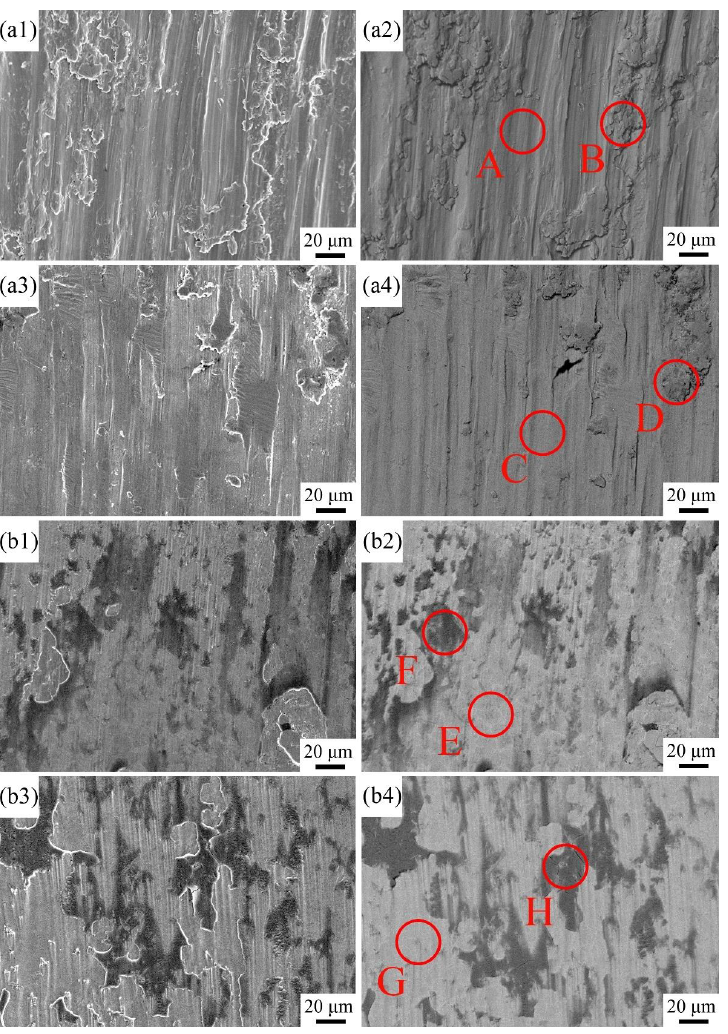
Figure 12. SEM and BSE images of the wear morphologies of the samples: the substrate of ( a1 , a2 ) for 2 h and ( a3 , a4 ) for 10 h; the CoCrFeNiAl coating of ( b1 , b2 ) for 2 h and ( b3 , b4 ) for 10 h.